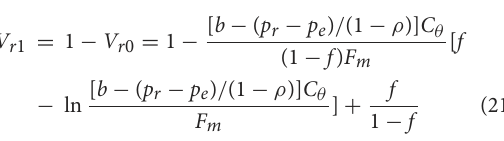
or f > f 2 , J ( x , y , f ) > 0, F ′ ( z ) | z = 1 < 0, and F ( z ) | z = 1 = 0 can be calculated, so z = 1 is stable. When x < x 2 , y > y 2 , or f < f 2 , J ( x , y , f ) < 0, F ′ ( z ) | z = 0 < 0, and F ( z ) | z = 0 = 0 can be calculated, so z = 0 is stable. When x = x 2 , y = y 2 , or f = f 2 , J ( x , y , f ) = 0, and F ′ ( z ) = 0 can be calculated, we are unable